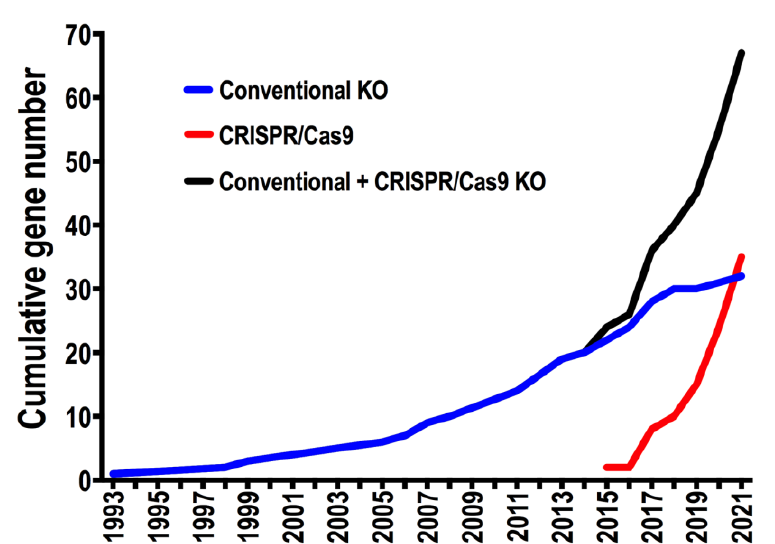
FIGURE 1: Impact of CRISPR/Cas9 technology on the generation of null mutants in Trypano- soma cruzi . Linear plots show the cumulative number of endogenous genes for which abla- tion attempts have been published per year in T. cruzi , using conventional knockout (blue), CRISPR/Cas9 (red), and the total number using either of the two methods (black). Only the first attempts reported for each gene were consid- ered in the